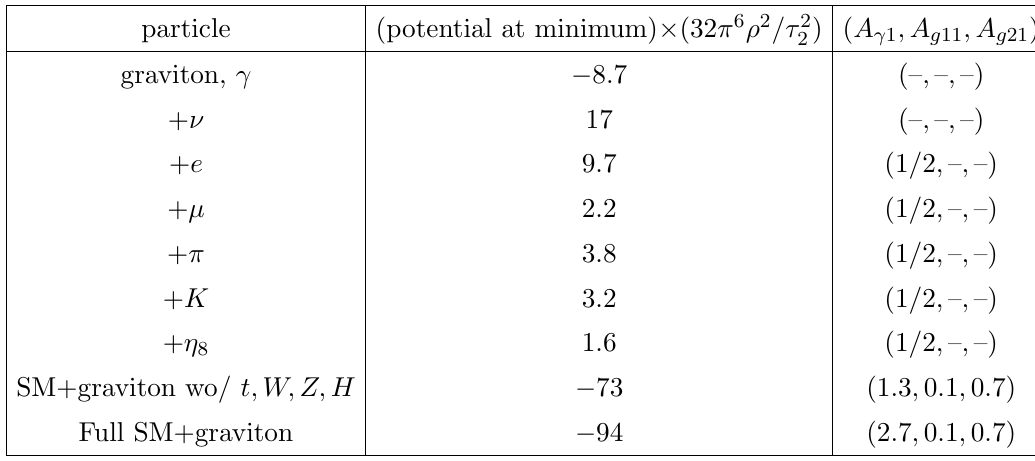
Table 6 . Same as (cid:12)gure 4, but for periodic, Dirac neutrinos. particle